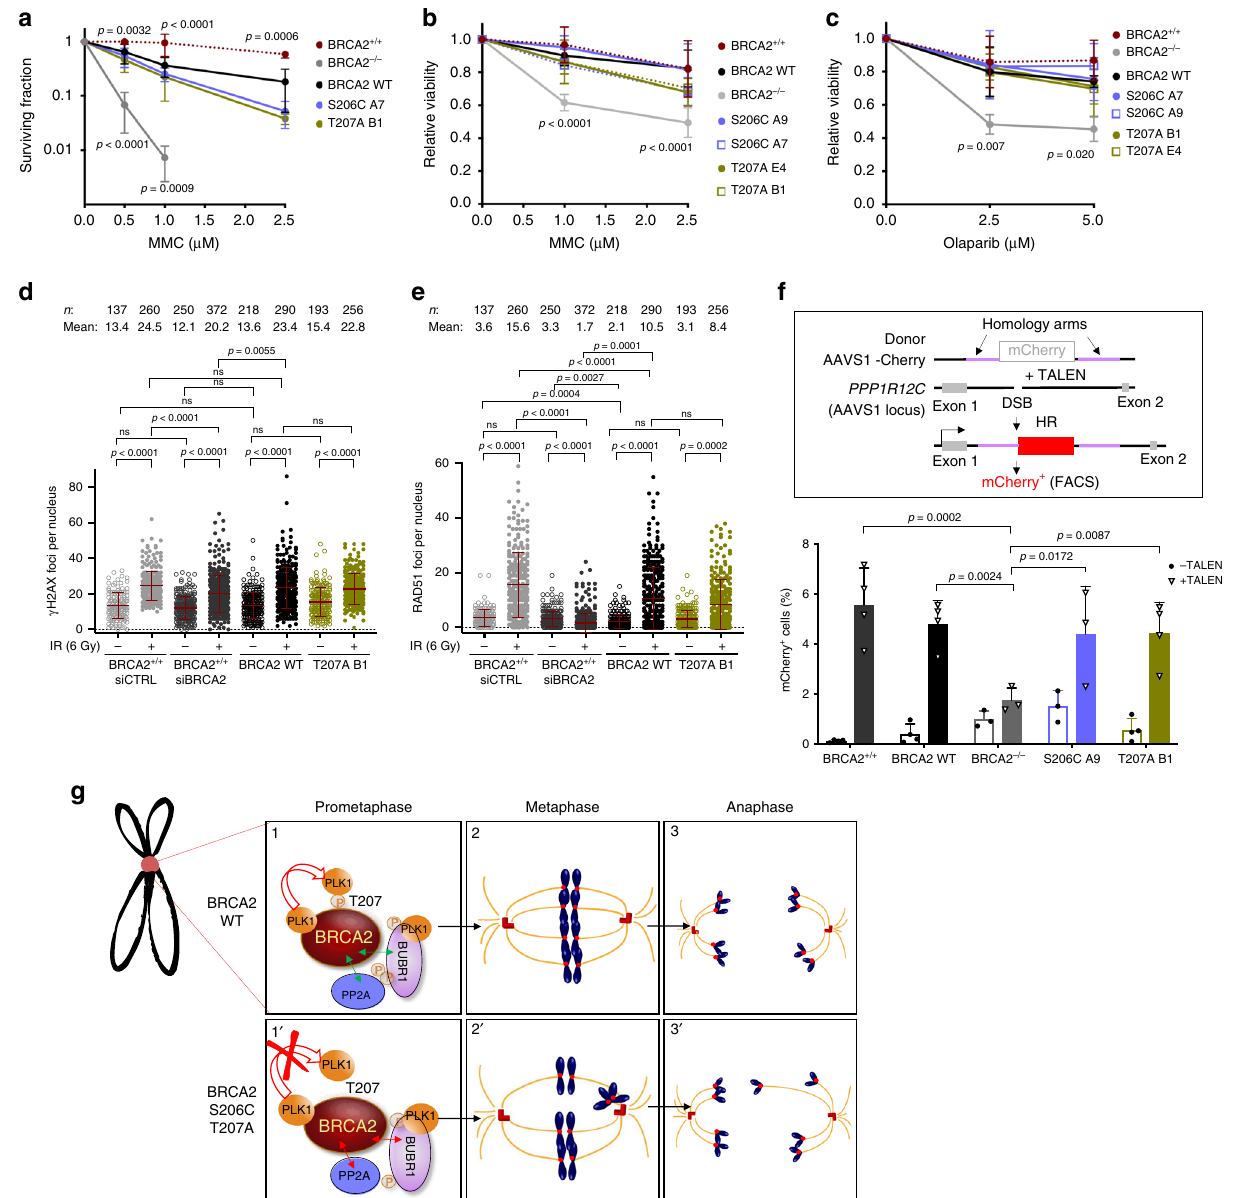
Fig. 9 The DNA repair pro fi ciency is not affected in cells bearing BRCA2 variants S206C and T207A. a Quanti fi cation of the surviving fraction of BRCA2 + / + or stable clones expressing BRCA2 WT or the variants S206C or T207A assessed by clonogenic survival upon exposure to MMC at concentrations: 0, 0.5, 1.0, and 2.5 µ M. Data are represented as mean ± SD: BRCA2 + / + (red) ( n = 3), BRCA2 − / − (gray) ( n = 6), WT C1 (black) ( n = 6), S206C A7 (blue) ( n = 3), T207A B1 (green) ( n = 4). b – c Quanti fi cation of the relative cell viability monitored by MTT assay upon treatment with increasing doses of MMC ( b ) or the PARP inhibitor Olaparib ( c ), as indicated. The data represent the mean ± SD of four ( b ) and three ( c ) independent experiments. a – c Two-way ANOVA test with Tukey ’ s multiple comparisons test was used to calculate statistical signi fi cance of differences (the p -values show the signi fi cant differences compared to the BRCA2 WT clone). d – e Quanti fi cation of the number of γ H2AX foci ( d ) or RAD51 foci per nucleus ( e ) 2 h after 6 Gy of γ -irradiation ( + IR) versus non-irradiated conditions ( − IR), in DLD1 BRCA2 + / + cells depleted of BRCA2 (siBRCA2) or control cells (siCTRL) or cells bearing BRCA2 WT or the variant T207A. n indicates the total number of cells counted from two independent experiments. Kruskal-Wallis one-way analysis followed by Dunn ’ s multiple comparison test was used to calculate statistical signi fi cance of differences. The red line in the plot indicates the mean ± SD, each dot represents a single focus. f Top: Scheme of the DSB-mediated gene targeting HR assay. Bottom: Frequency of mCherry positive cells in cells transfected with the promoter-less donor plasmid (AAVS1-2A-mCherry) without ( − TALEN) or with ( + TALEN) nucleases. The error bars represent mean ± SD of three to four independent experiments (BRCA2 + / + ( n = 4), WT ( n = 4), BRCA2 − / − ( n = 3), S206C A9 ( n = 3), T207A B1 ( n = 4)). Two- way ANOVA test with Tukey ’ s multiple comparisons test. g Model for the role of PLK1 phosphorylation of BRCA2 T207A by PLK1 in mitosis (see text for details). In panel 1 and 1 ′ the two-sided arrows represent a complex between the two proteins as indicated either favored by BRCA2 WT (green) or impaired in the BRCA2 mutated form (red); in panels 2, 2 ′ , 3 and 3 ′ blue blobs represent chromosomes, red circles represent the kinetochores, red cylinders represent the centrioles and orange lanes represent the spindle microtubules. Source data are available as a Source Data fi